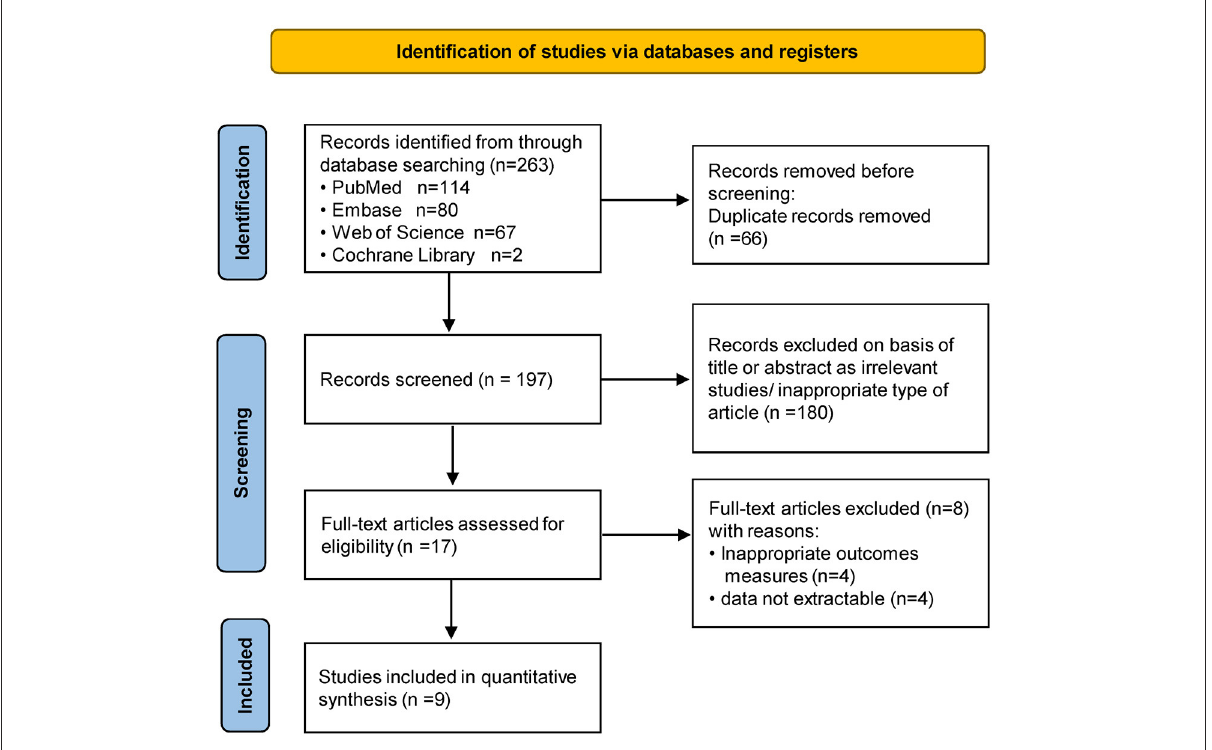
FIGURE1 PRISMA flow diagram of study